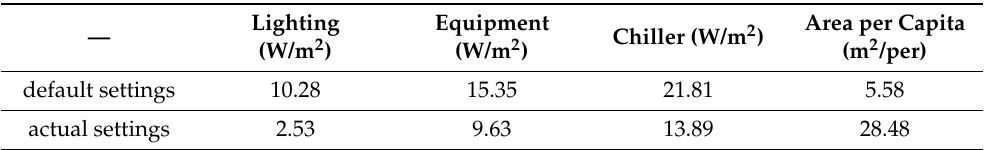
Table 3. Calibration comparison of static power density